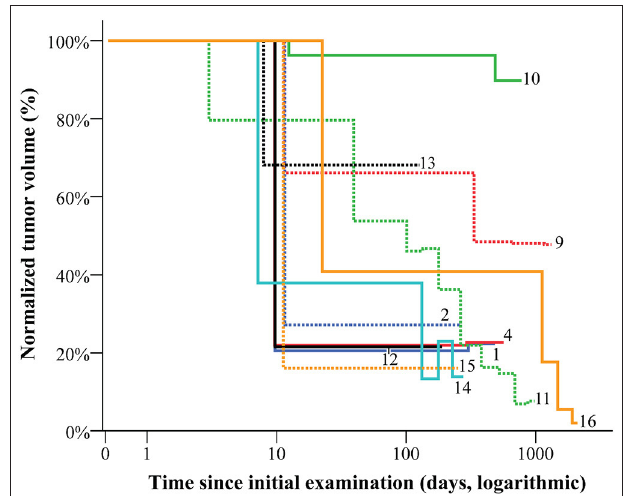
FIGURE 6 | The volume of vascular anomalies during therapy and early follow-up. The normalized volume of vascular anomalies was calculated considering the factor of patients’ growth when assessing the response to therapy. The most remarkable volume reductions are to be detected within the first 4–6 months of